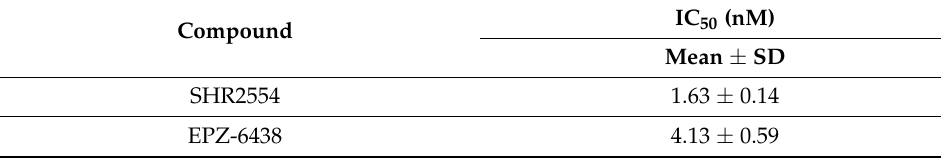
Table 2. Effect of SHR2554 on H3K27me3 in Pfeiffer